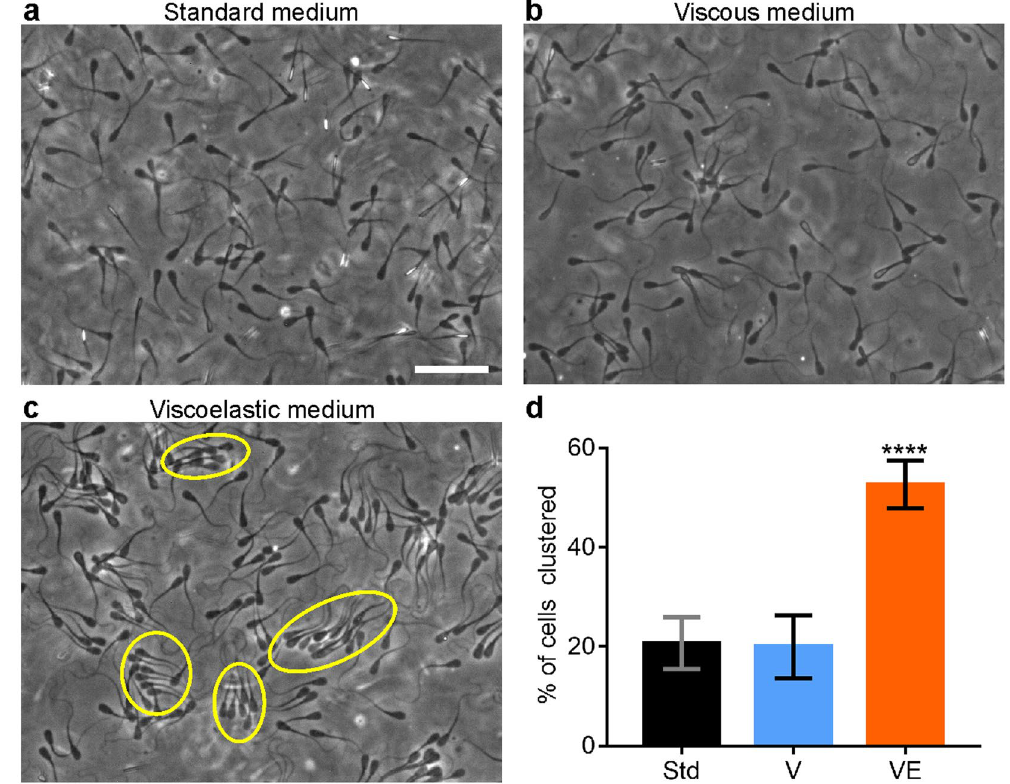
Figure 1. Different collective behaviours of swimming sperm in Newtonian and viscoelastic fluids. ( a ) In standard medium, sperm swam individually. Scale bar: 50 μ m. ( b ) In a Newtonian viscous medium (3% PVP), most sperm swam individually. ( c ) In viscoelastic medium (1% LC-PAM), sperm swam collectively and formed clusters. ( d ) Percentage of sperm found in clusters (including pairs) in standard medium (Std), Newtonian viscous medium (V), and viscoelastic medium (VE). The definition of cluster is when the sperm are within 17.5 µ m each other, and their head orientation is within 20°. **** p < 0.0001, compared to standard medium, from one-way ANOVA with multiple